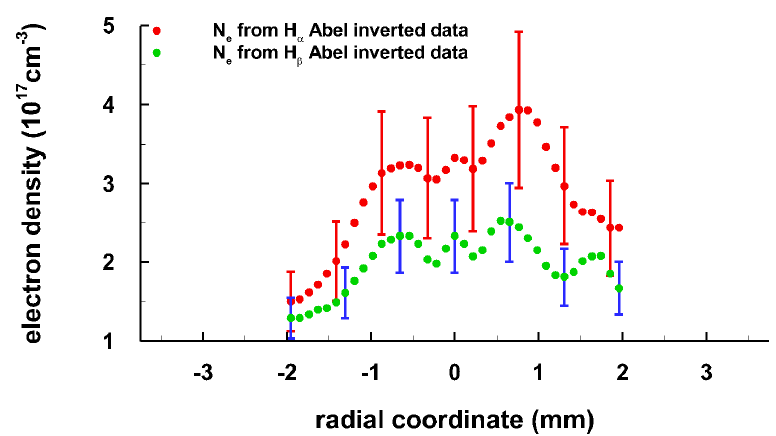
Figure 5. Electron density, n e , vs. radial position [15].